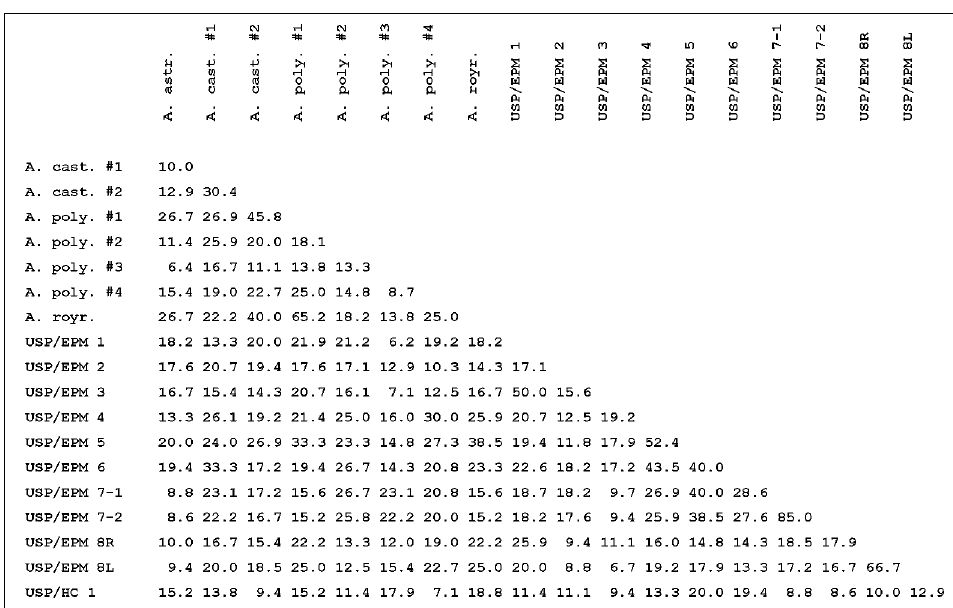
Figure 3 - Matrix showing pair- wise similarities calculated for RAPD profiles obtained with primers 606, 688 and 694. For abbreviations, see legend to Fig- ure